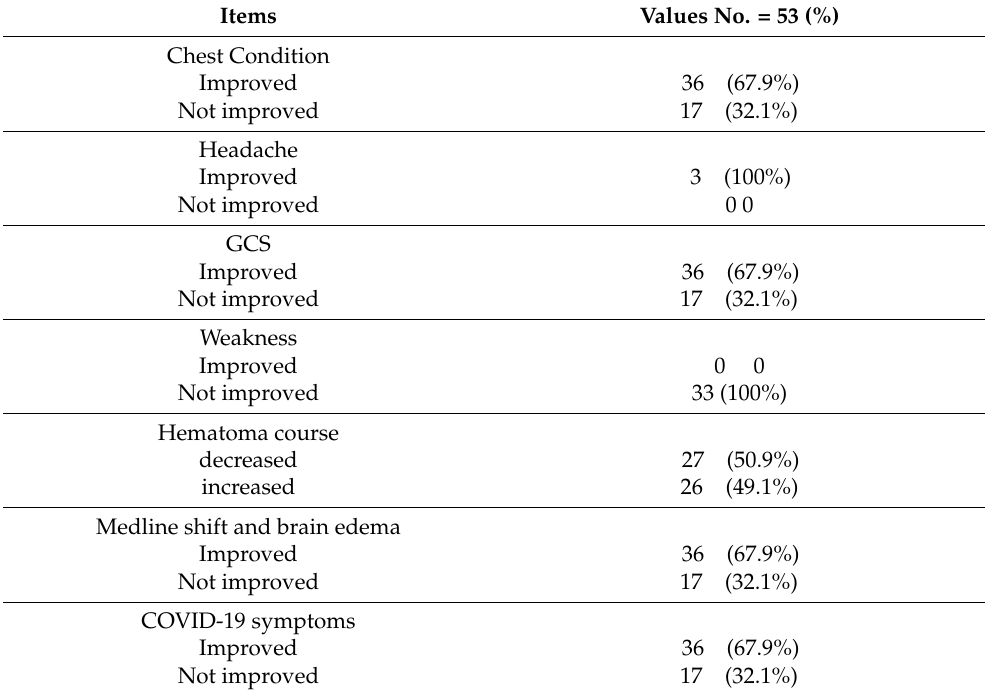
Table 4. The outcomes of the studied